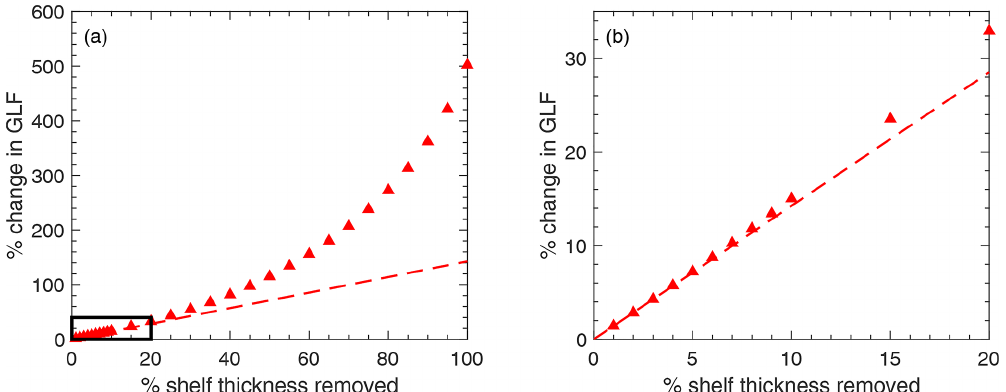
Figure B2. The percentage change in grounding line flux is plotted as a function of the “proportional” thickness perturbation applied (a) . The dashed line is the straight line that passes through the origin and the 1% “proportional” thinning point. Panel (b) is the region shown in the black box in panel (a)